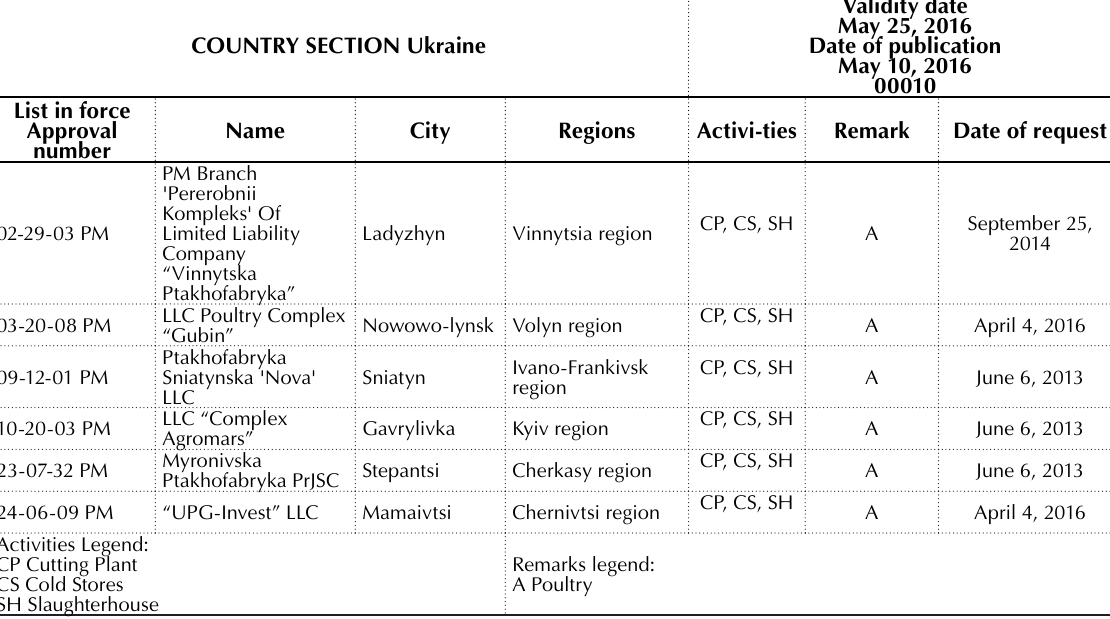
Table 4. List of poultry producers that are allowed to export to